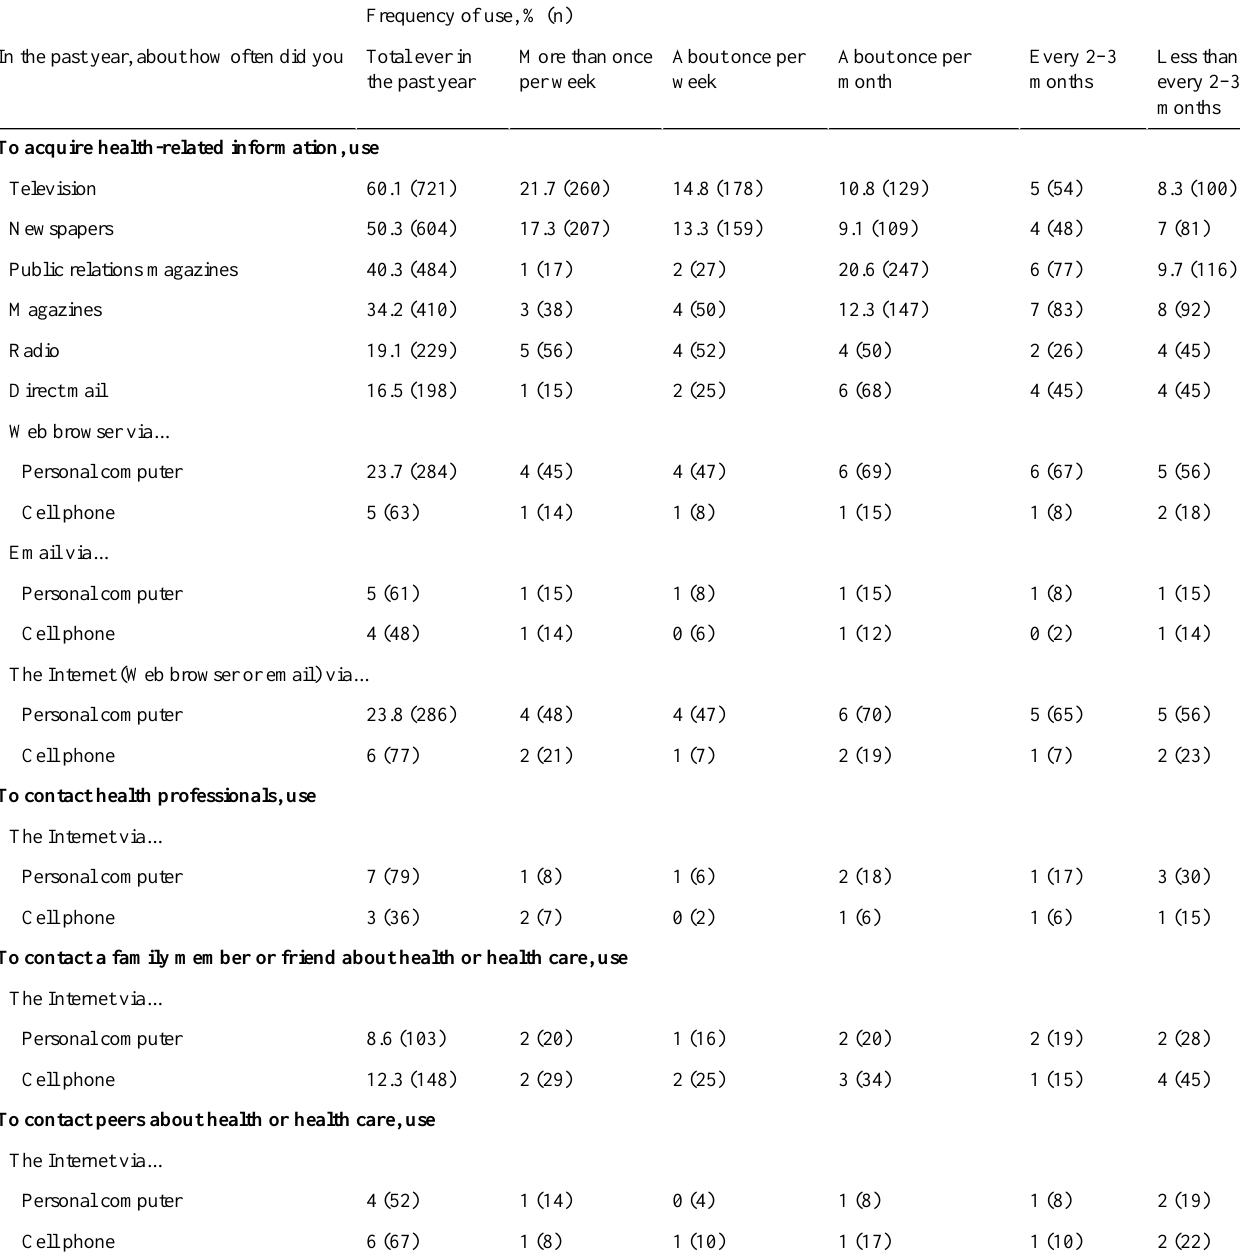
Table 2. Prevalence and frequency of Internet use for health purposes (N = 1200)